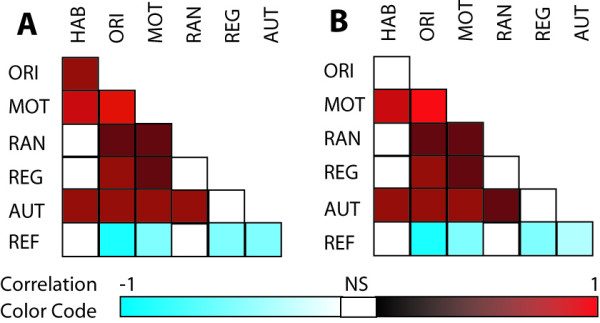
Correlation structure of the NBAS cluster scores in all neonates (A) and neonates with the CBL levels below 10 μg/dL (B). The color codes at the bottom provide a reference for the magnitude and significance of the Pearson correlation coefficients. Open boxes represent statistically non-significant correlation coefficient. The actual estimates of correlation coefficients and their significance values are shown in Supplementary Table 3 (see additional file 1, supplementary table 3). The NBAS clusters shown here are: habituation (HAB), orientation (ORI), motor (MOT), range of state (RAN), regulation of state (REG) and autonomic stability (AUT) and abnormal reflexes (REF).